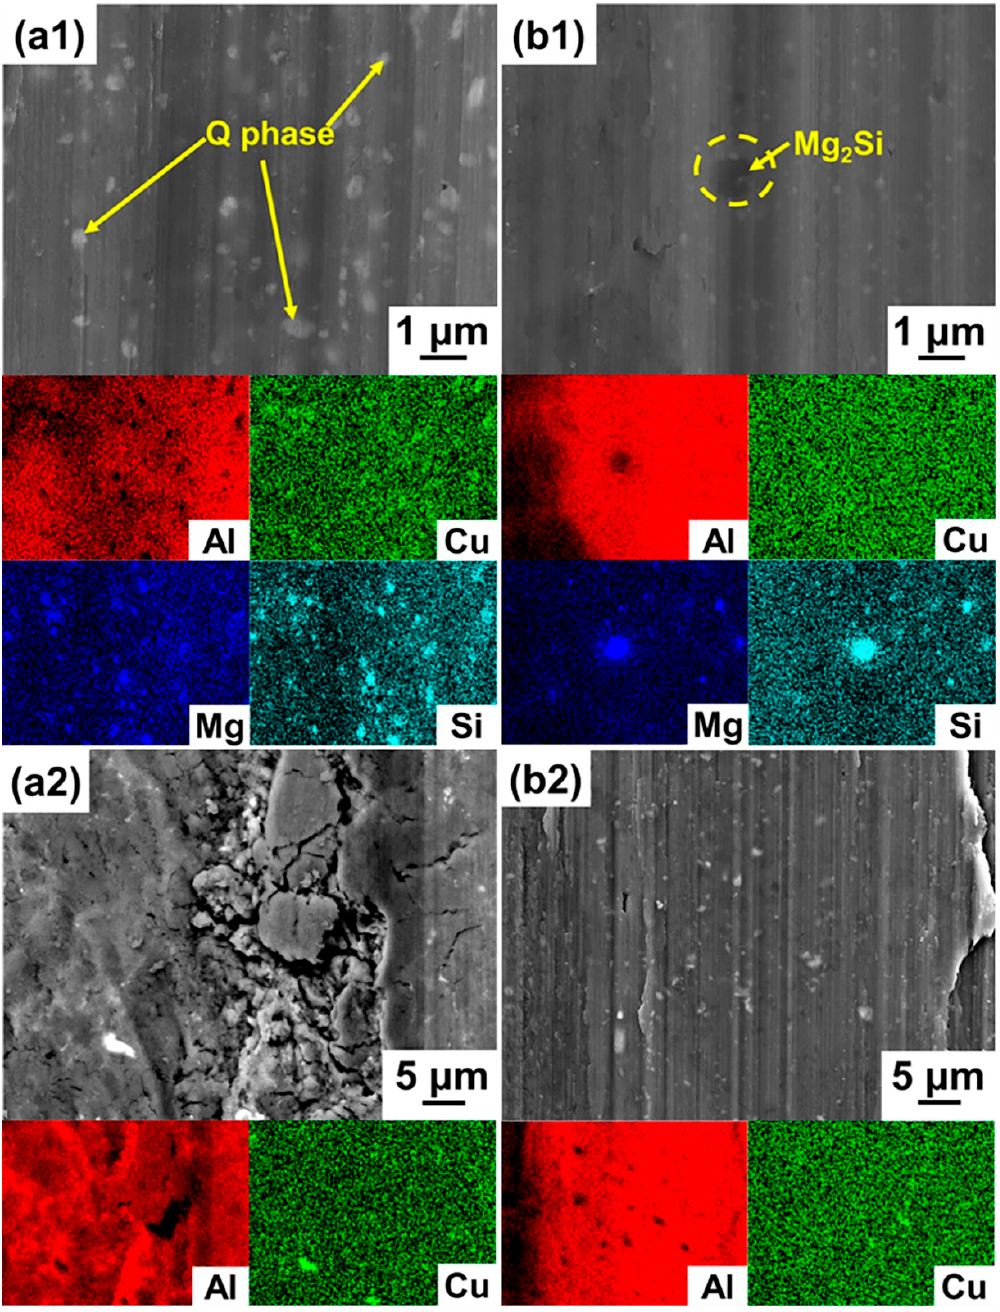
Figure 7. SEM close-up view and EDS maps at high magnification in SE mode: ( a1 ) The as-SLM alloy; ( b1 ) SLM-T6 alloy; ( a2 ) AA2024-O alloy; ( b2 ) AA2024-T6 alloy.